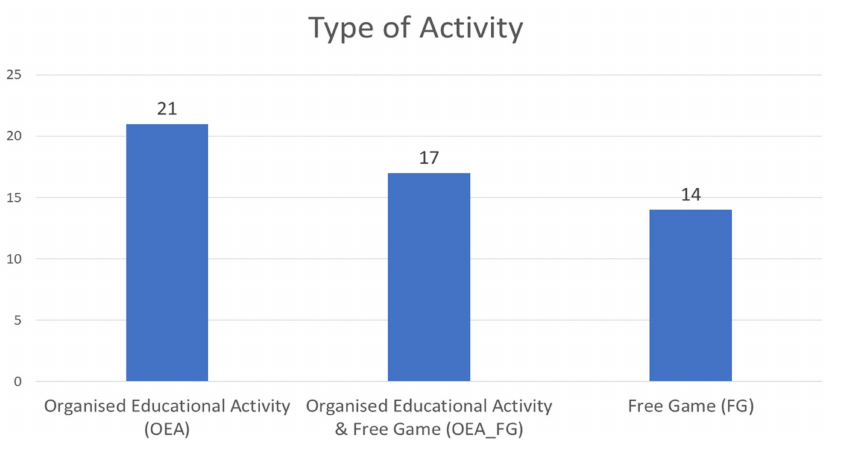
Figure 5. Types of activities and smart